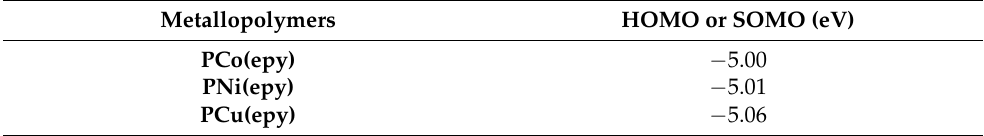
Table 1. The HOMO or SOMO energies of PM(epy) .